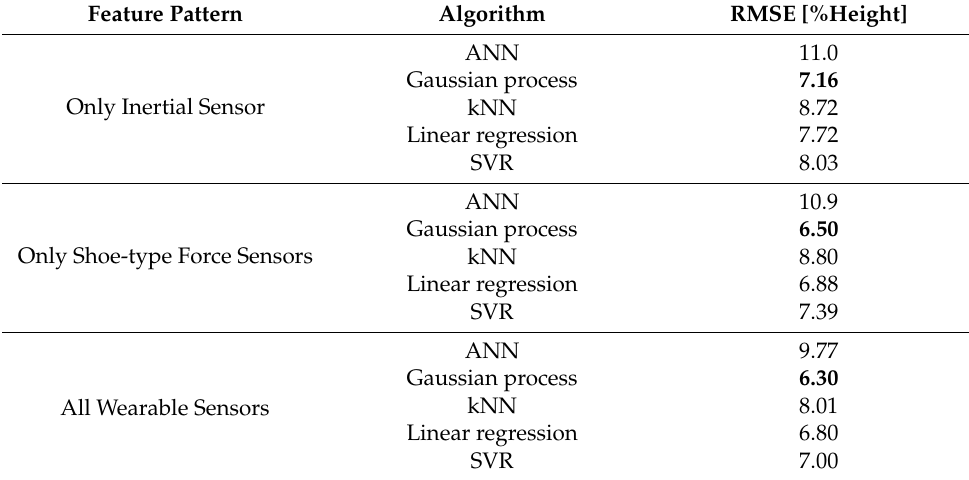
Table 8. Root mean square error values of mediolateral foot